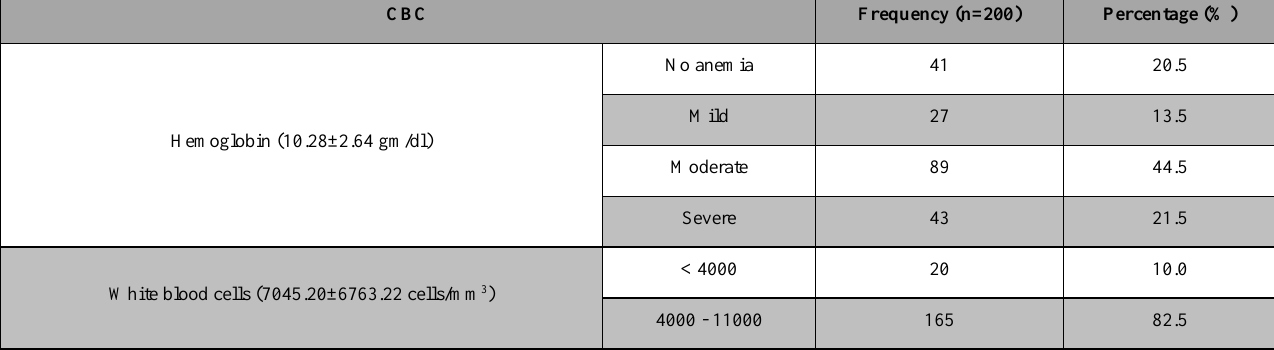
Table 1. Distribution according to complete hemogram of patients with